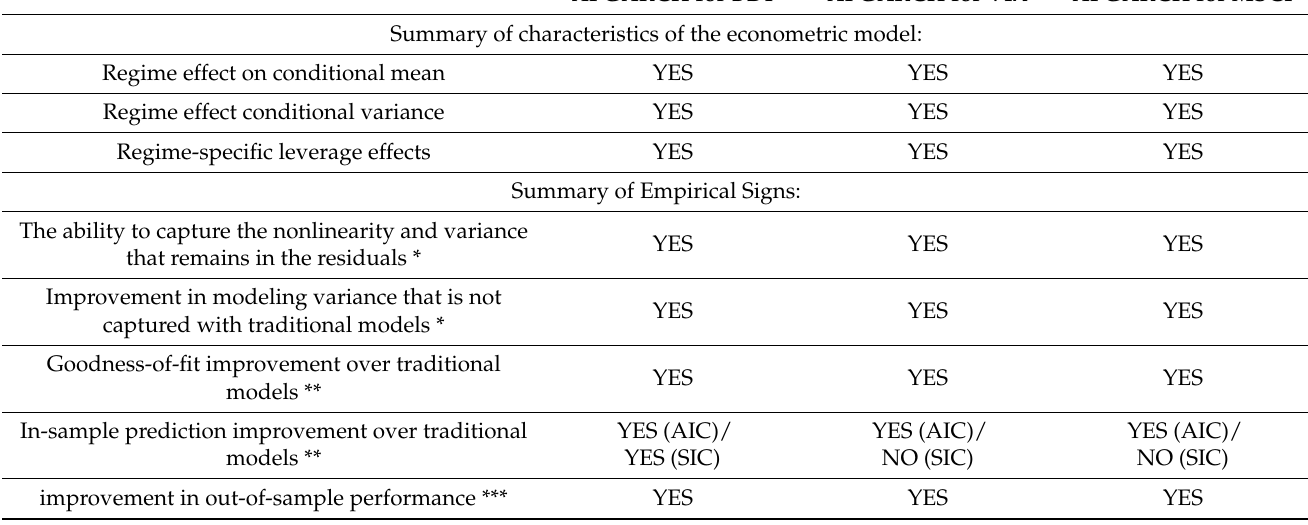
Table 8. Summary of Key Results. LSTAR-GARCH and LSTAR-GARCH and LSTAR-GARCH and APGARCH for BDI APGARCH for VIX APGARCH for MSCI Summary of characteristics of the econometric